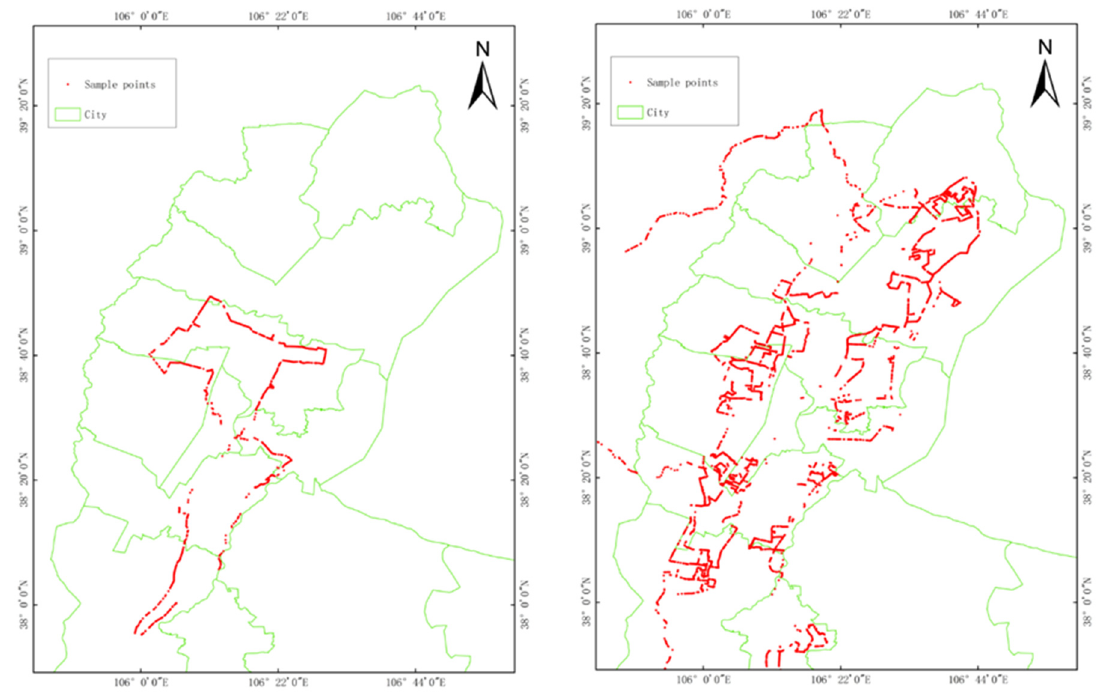
Figure 2. The field samples in the study area for 2017 ( left ) and 2018 ( right ).